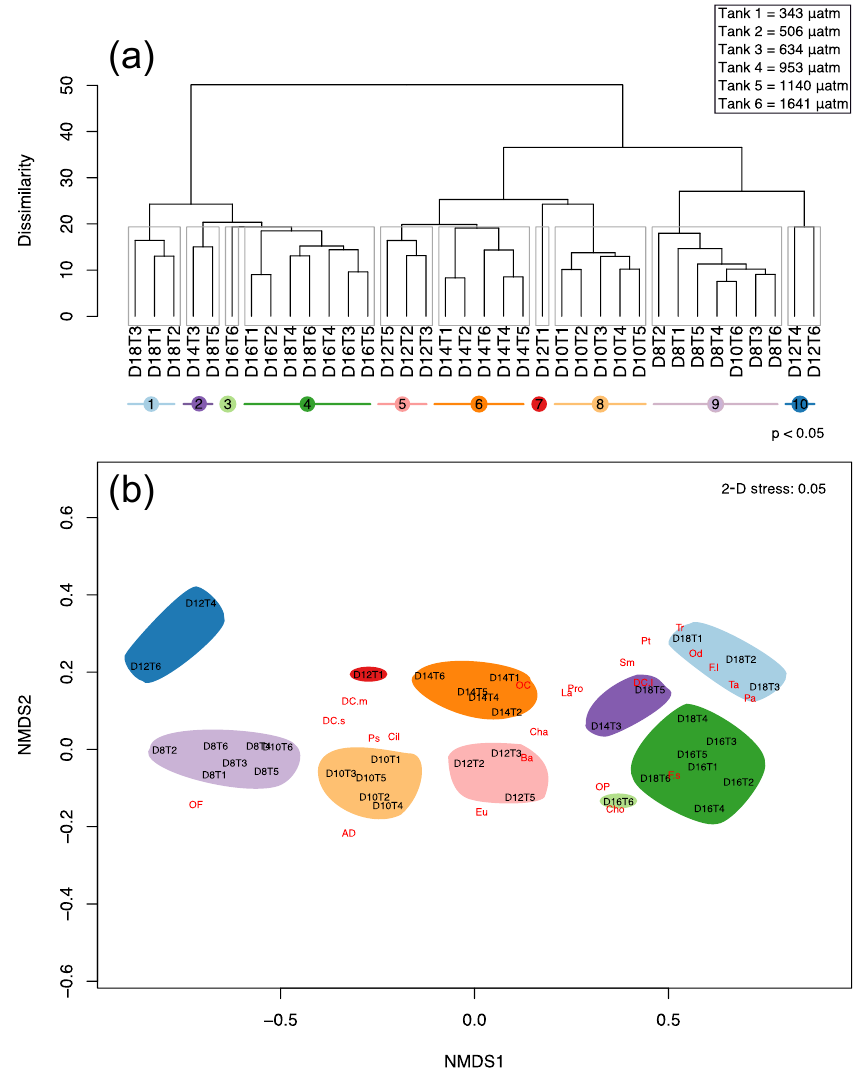
Figure 10. Cluster analysis and nMDS based on similarity in protistan community structure among f CO 2 treatments and times over days 8 to 18 of the incubation. (a) The cluster analysis with ten significantly different groups obtained by SIMPROF (denoted by grey boxes around clusters and coloured lines beneath sample labels). (b) nMDS plot structure of the unconstrained ordination of dissimilarities in protistan community structure with time and f CO 2 treatment in two dimensions, overlaid with weighted-averages of the day-treatment scores for each protistan taxa/functional group (see Table 1 for abbreviations). Samples are abbreviated according to days of incubation (D8–18) and f CO 2 treatment (T1–6 representing 343, 506, 634, 953, 1140, 1641µatm,